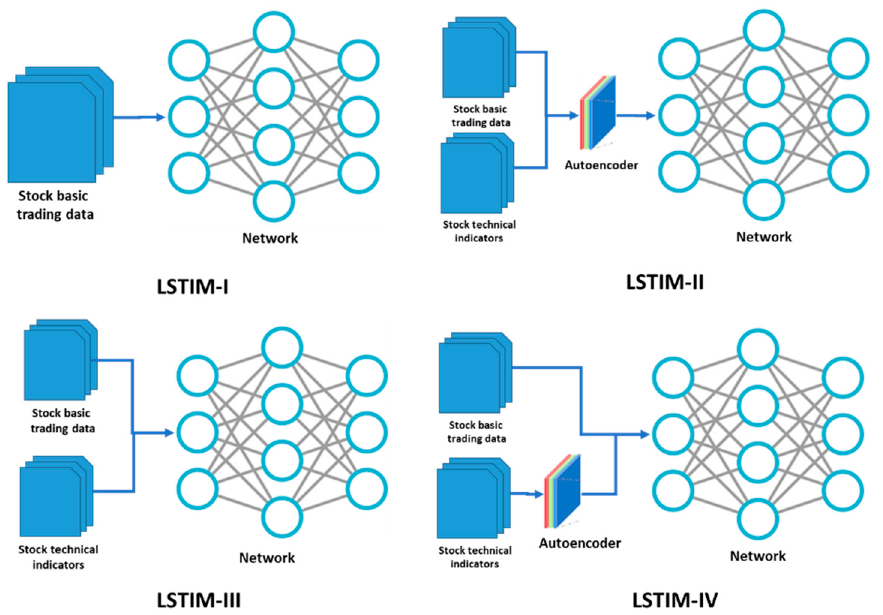
Figure 4. Different input methods for the LSTM.